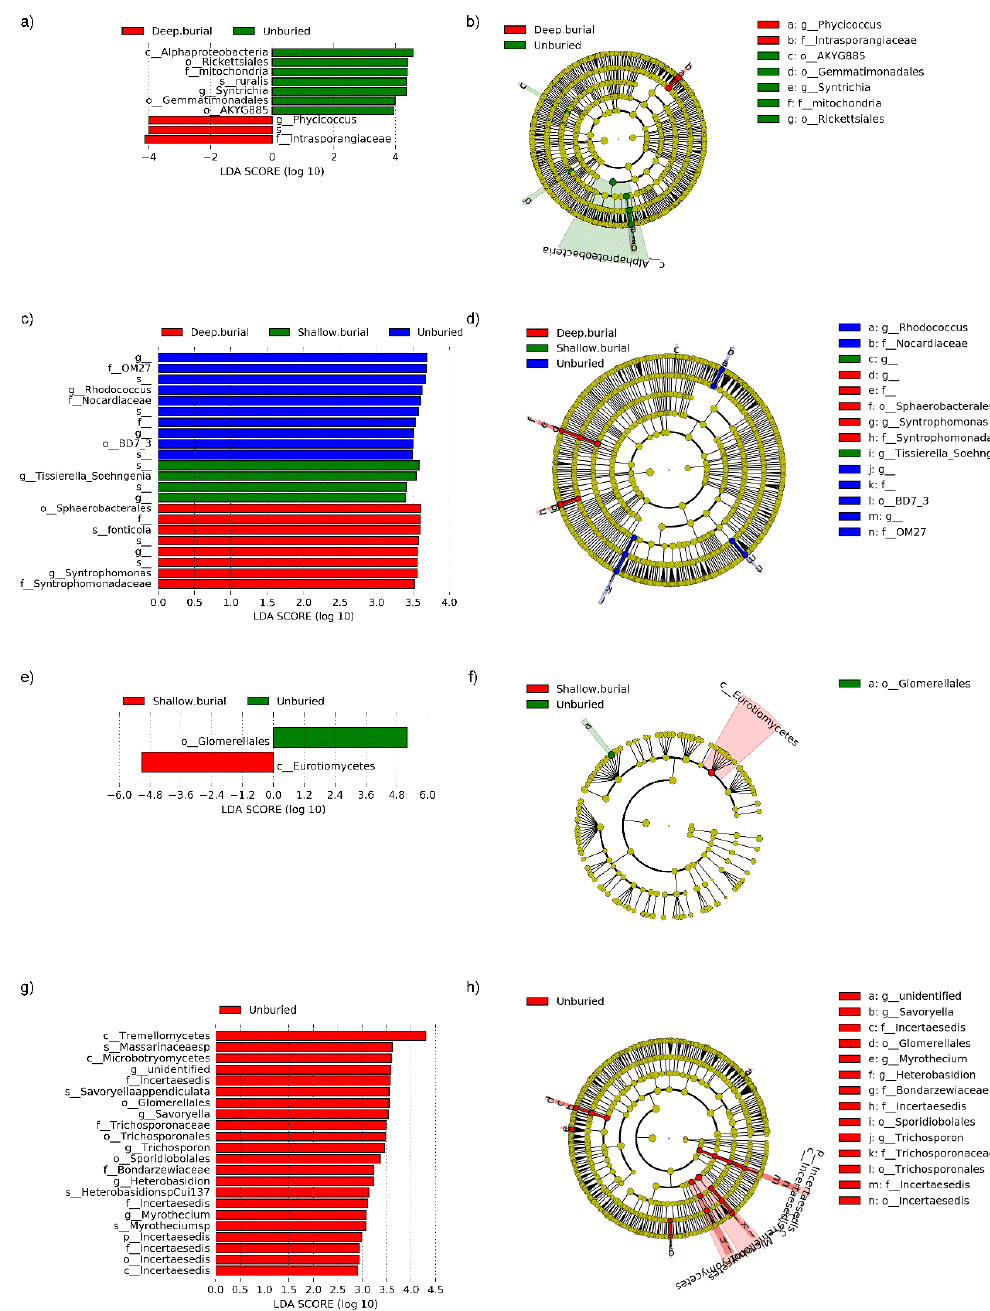
Figure 6. Cladogram indicates the phylogenetic distribution of microbial lineages under different succession periods, and each circle’s diameter is proportional to the given taxon’s relative abundance. Different colors represent different treatments and dominant taxonomy groups. ( a ) Indicator bacteria with linear discriminant analysis (LDA) scores of 2 or greater in bacterial communities under different soil depths during early succession. ( b ) Phylogenetic distribution of bacterial lineages under different soil depths during early succession. ( c ) Indicator bacteria with LDA scores of 2 or greater in bacterial communities under different soil depths during late succession. ( d ) Phylogenetic distribution of bacterial lineages under different soil depths during late succession. ( e ) Indicator fungi with LDA scores of 2 or greater in fungal communities under different soil depths during early succession. ( f ) Phylogenetic distribution of fungal lineages under different soil depths during early succession. ( g ) Indicator fungi with LDA scores of 2 or greater in fungal communities under